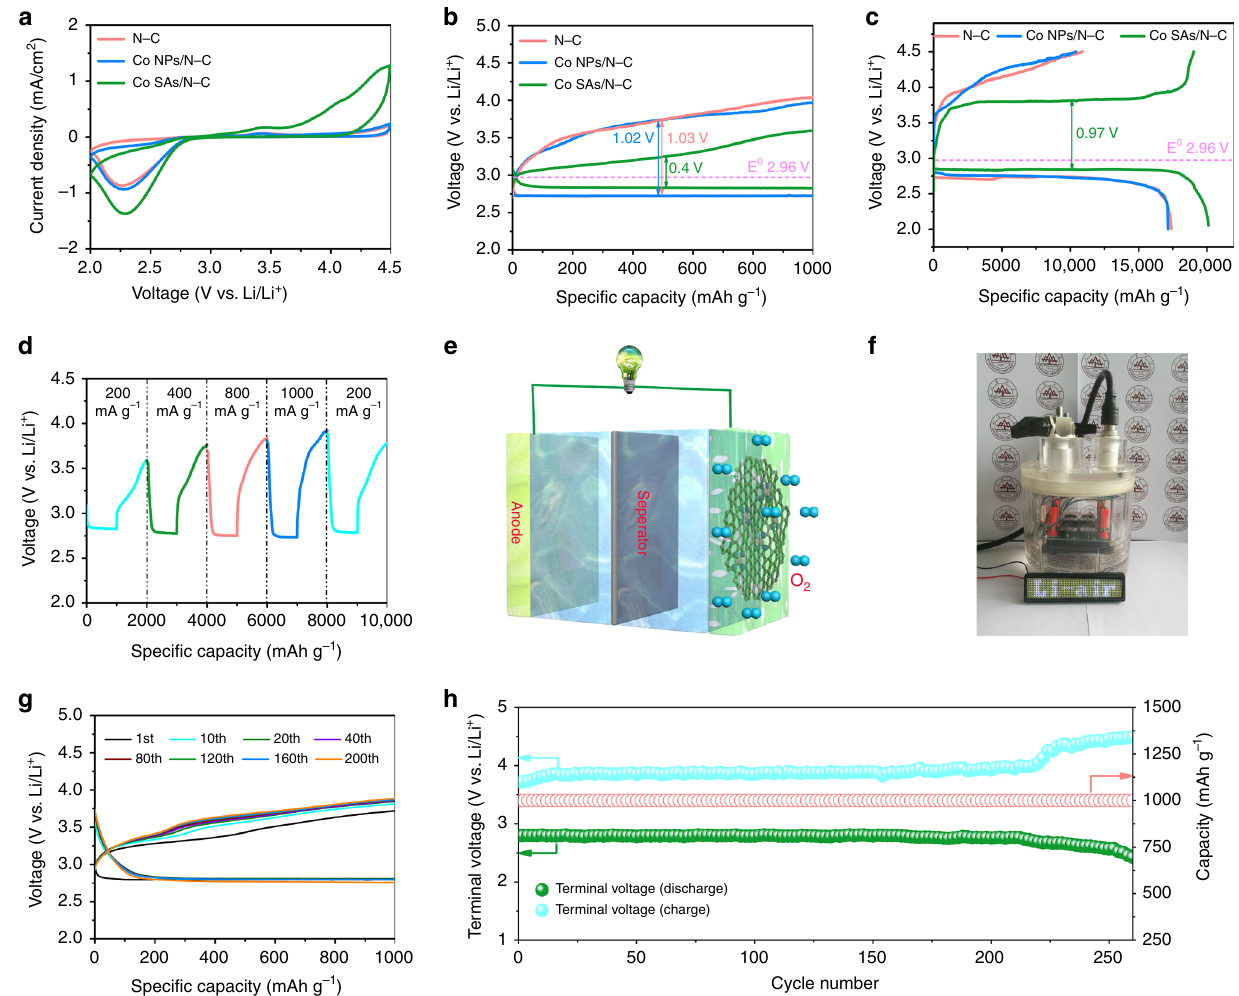
Fig. 3 Electrochemical performance of Co-SAs/N-C, Co-NPs/N-C and N/C electrodes. a CV curves of Co-SAs/N-C, Co-NPs/N-C and N/C electrodes at a scan rate of 0.1 mV s − 1 at a voltage window of 2.0 – 4.5 V. b The discharge – charge curves of Co-SAs/N-C, Co-NPs/N-C, N-C electrodes at a curtailed capacity of 1000 mAh g − 1 at a current density of 200 mA g − 1 . c The initial deep discharge – charge curves of Co-SAs/N-C, Co-NPs/N-C, N-C electrodes at a current density of 200 mA g − 1 . d The discharge – charge pro fi les of Co-SAs/N-C electrode at various current densities ranging from 0.2 to 1.0 A g − 1 at a cut-off capacity of 1000mAh g − 1 . e The con fi guration model of a Li-O 2 battery based on Co-SAs/N-C. f Photo image of the LED turned on by four as- fabricated Co-SAs/N-C based Li-O 2 batteries. g Discharge – charge pro fi les of Co-SAs/N-C based electrode with different cycles at 400 mA g − 1 . h Cycling stability and terminal discharge – charge voltages of Co-SAs/N-C electrode at 400mA g − 1 with a limited capacity of 1000 mAh g − 1 Both the lithiation and delithiation potentials can sustain steady corresponding discharge/charge voltage reaching about 2.52/4.36 over a long period of cycling lifespan, featuring a prominent V at 1.0 A g − 1 . On the other hand, when we set back the current cycling reliability. In sharp contrast, as seen in Supplementary Fig. 17, 18, Co-NPs/N-C and N-C involved Li-O 2 cells both suffer severe overpotential loss and can only maintain 80 and 60 cycles, respectively, with the OER terminal potential quickly increasing to model of Co-SAs/N-C-based Li-O 2 battery. Figure 3f exhibits the 4.5 V. Furthermore, we carried out cycling measurements under operation installation of four Li-O 2 button cells based on Co-SAs/ 400 mA g − 1 with extended cut-off capacity of 12,000 mAh g − 1 N-C electrode in successfully powering a light-emitting diode (the corresponding depth of discharge is close to 75%) via the (LED) array. Long-term cycling performance as another crucial achievable Co-SAs/N-C catalyst, For comparison, the ORR/OER indicator is assessed. The discharge/charge pro fi les of the Co-SAs/ capacities are limited within 3500 mAh g − 1 (the discharge depth N-C coupled cell for various cycles under 400 mA g − 1 (Fig. 3g) exhibit striking overlap ratio, indicating obviously improved cycle is close to 35%) for N-C catalysts. As observed in Supplementary stability. Even after 200 cycles, the terminal ORR and OER Fig. 19a, Co-SAs/N-C based cells can operate very stable for at potentials of Co-SAs/N-C can still maintain at 2.7 and 3.9 V, least 18 cycles under deep charge/discharge processes. In contrast, yielding overall overpotential still at lower level, which is of vital N-C based cells can only maintain 12 cycles even under much importance in suppressing the intractable parasitic reactions lower cut-off capacity (Supplementary Fig. 19b). This fi nding stemmed from electrolyte instability. Figure 3h shows that the further demonstrates the advantage of the Co-SAs/N-C hybrid in 2032 cell based on Co-SAs/N-C can well operate for up to 260 dramatically ameliorating overpotential and enhancing cycling cycles at 400 mA g − 1 under a curtailed capacity of 1000 mAh g − 1 . durability of lithium-oxygen batteries. Thus, we conclude the